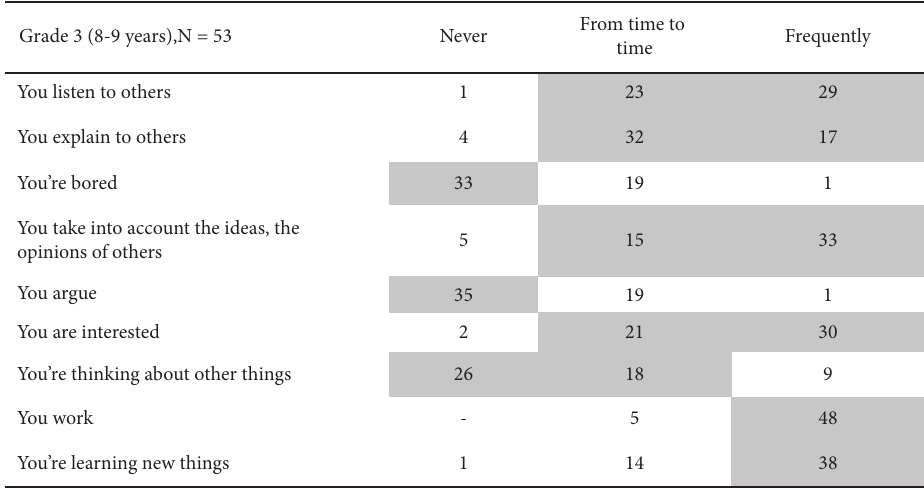
Figure 5: Breakdown of opinions among pupils in grade 3 based on how they work in a group (significance level of p � 0 . 01).